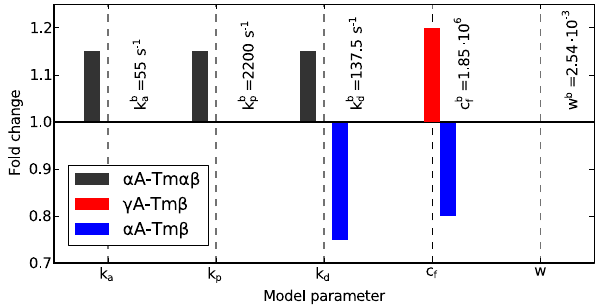
Figure 7. Fold changes in model parameters. The model parameters of the regulated conditions ( a A-Tm ab , c A-Tm b , and a A- Tm b ) are shown, normalized by the parameters determined for the baseline condition, whose values are displayed to the right of the